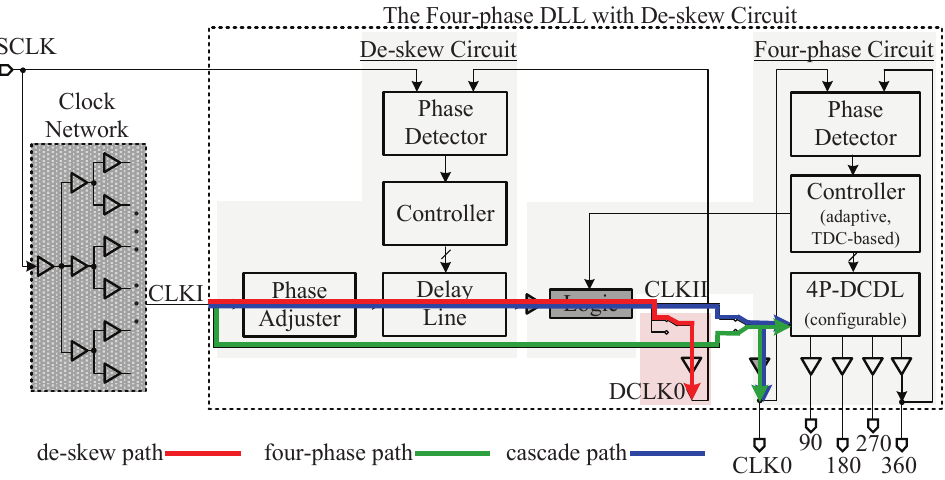
Figure 11. The delay paths of the proposed parallel-cascaded configuration.